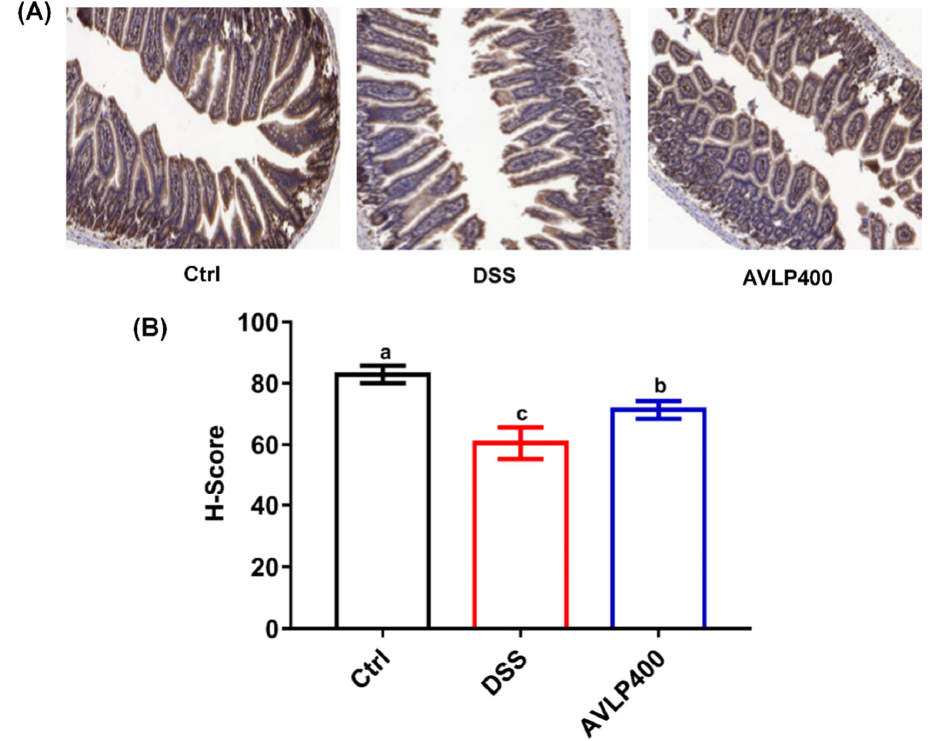
Figure 4. Effect of AVLP on ZO-1 protein expression in colitis mice. ( A ) Representative images of IHC staining. ( B ) H-Score of IHC staining. Significant differences ( p < 0.05) are indicated with different letters.